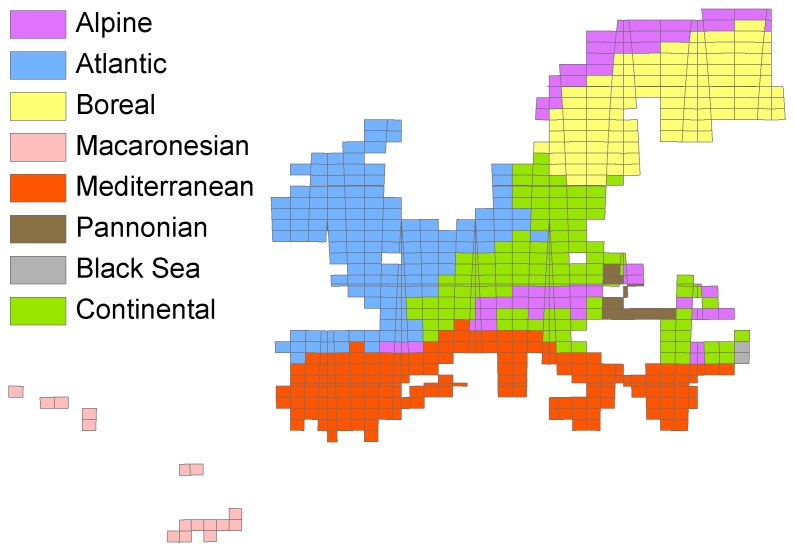
Biogeographical regions of Europe.(http://www.eea.europa.eu/data-and-maps/data/biogeographical-regions-europe-2008) resulting from the ‘Map of Natural Vegetation of the member countries of the European Community and of the Council of Europe’ (Bohn et al., 2000-2004) rescaled at the resolution level of the MGRS pixels.